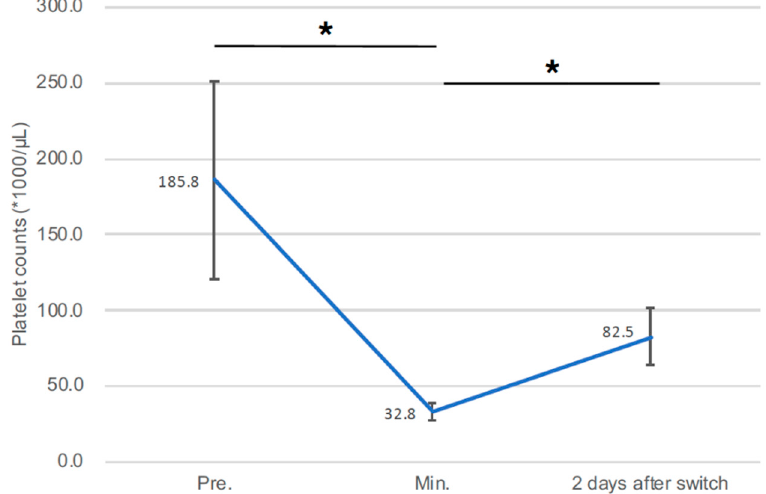
Figure 3. The drop and recovery of platelet counts in four survivor patients under Impella 5+ support accompanied by HIT-positive diagnostic. Min., minimum; HIT, heparin-induced thrombocytopenia; Impella 5+, Impella 5.0 or 5.5; Pre., preimplantation of Impella 5+; * p <